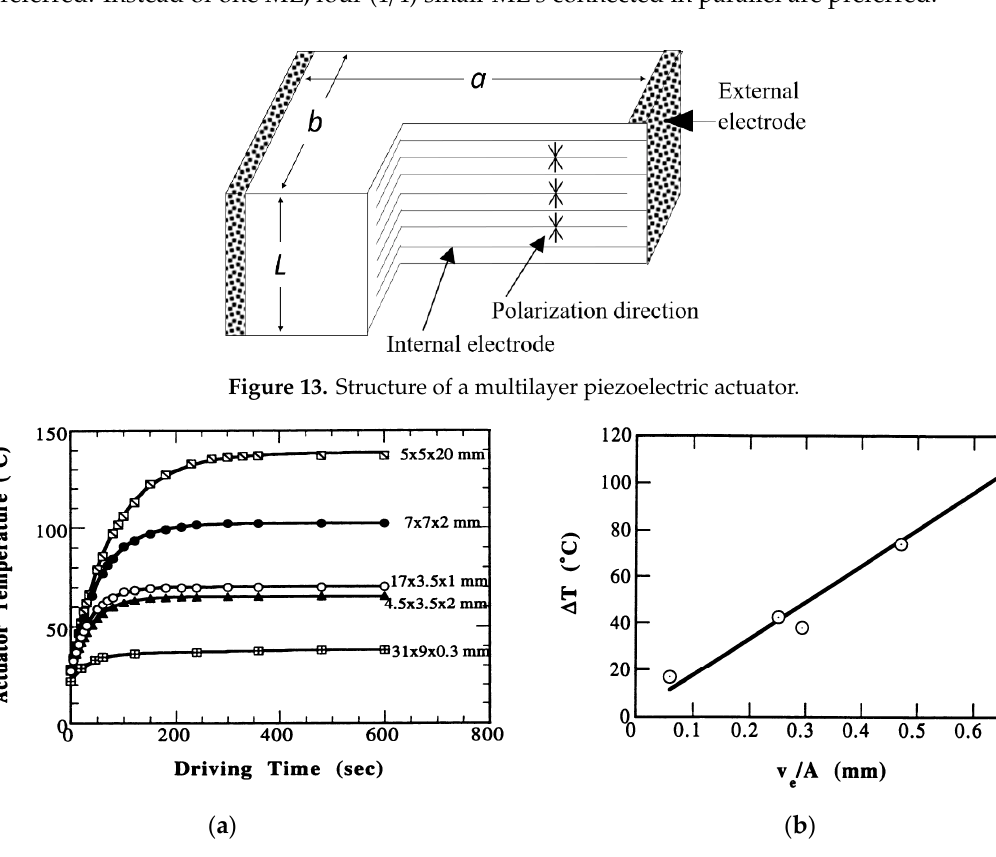
Figure 14. ( a ) device temperature change with driving time for ML actuators of various sizes; ( b ) temperature rise at off-resonance versus V e / A in various size soft PZT ML actuators, where V e and A are the effective volume and the surface area.